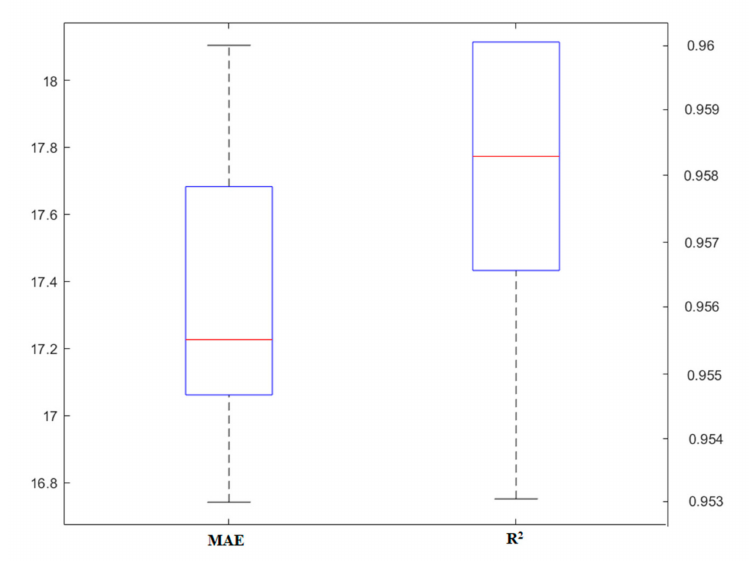
Figure 7. The results of the random tree (RT) model, based on the number of models.